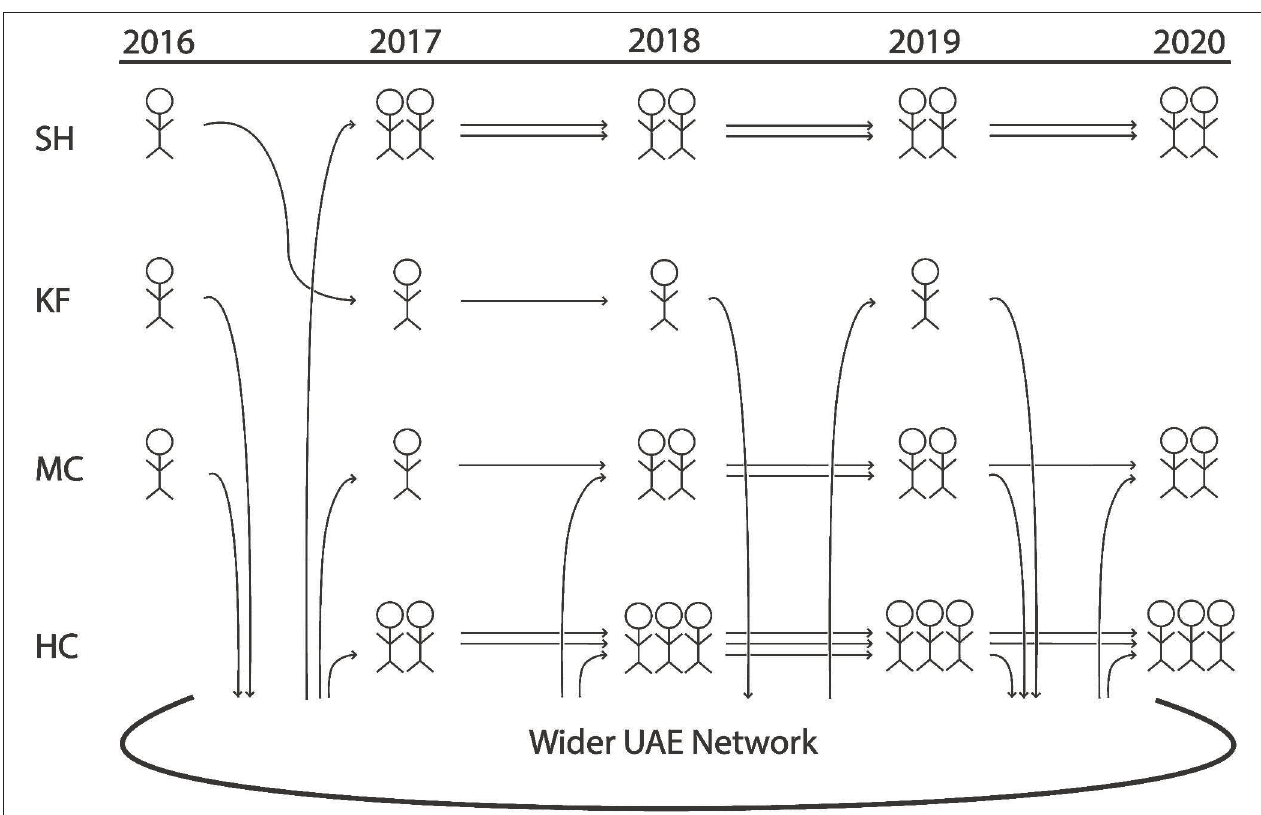
FIGURE 4 | Community Partner Transitions. This figure depicts some of the transitions our current partners have experienced. We show growers/coordinators joining from and leaving to the wider urban agroecology (UAE) network because, like the many additional partners from the 2016 projects, we as researchers and community partners retain connections and communication with former project members. Between 2016 and 2017, we see that each partner experienced a grower transition or newly joined as a partner, in the case of the Healing Garden Coalition (HC); this season also marked the end of the 2016 community- and researcher-initiated projects and the start of the current ecosystem services exploration in late 2017. The farmers at Sandhill Farm (SH) have remained the same during the current project, but the farmer at Knoll Farm (KF) has changed nearly every year. Growers and coordinators have transitioned in and out of both Mazahua Center (MC) and HC, but continuity and institutional memory has largely been maintained because at least one individual at each organization has remained. Finally, it’s important to note that during spring 2020—concurrent with the COVID-19 pandemic—three of our four partners experienced significant